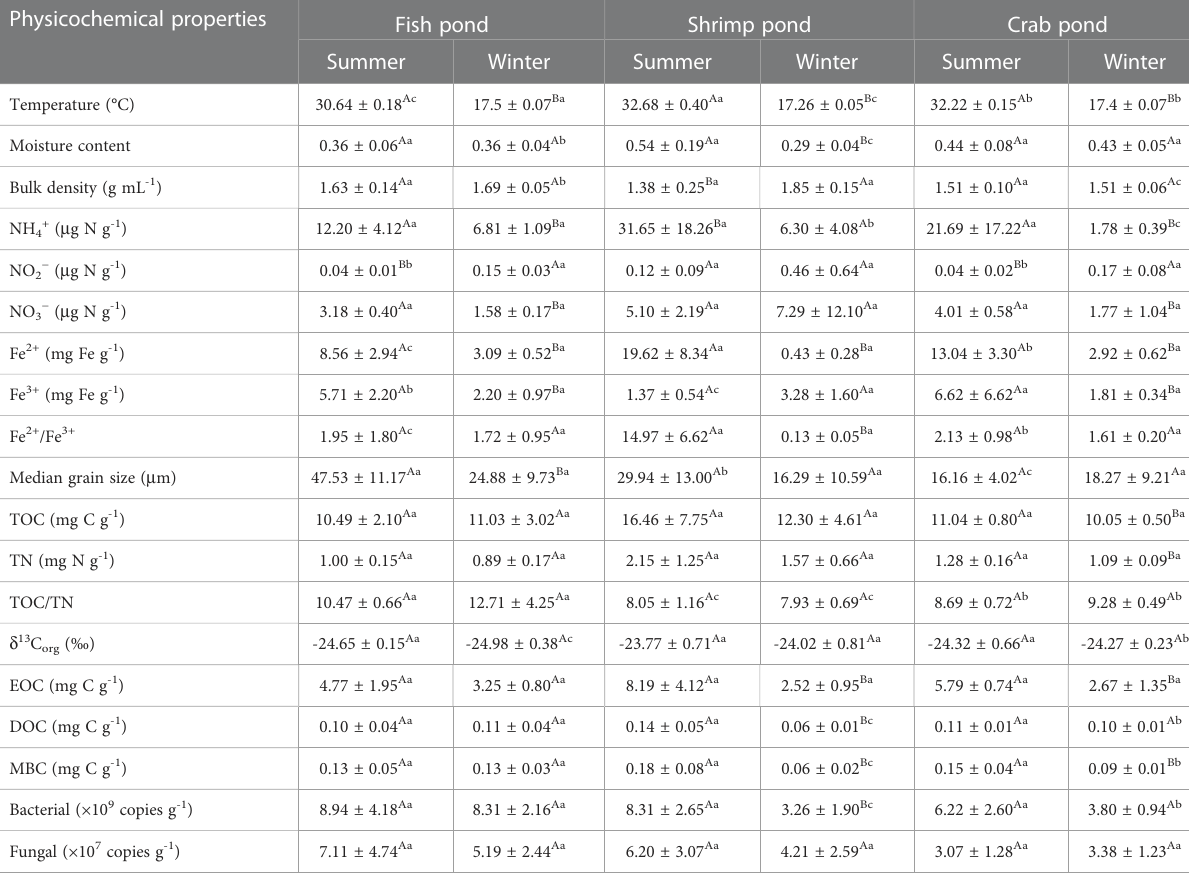
TABLE 2 Spatiotemporal variations of sediment physicochemical properties in different reclaimed aquaculture ponds. Physicochemical